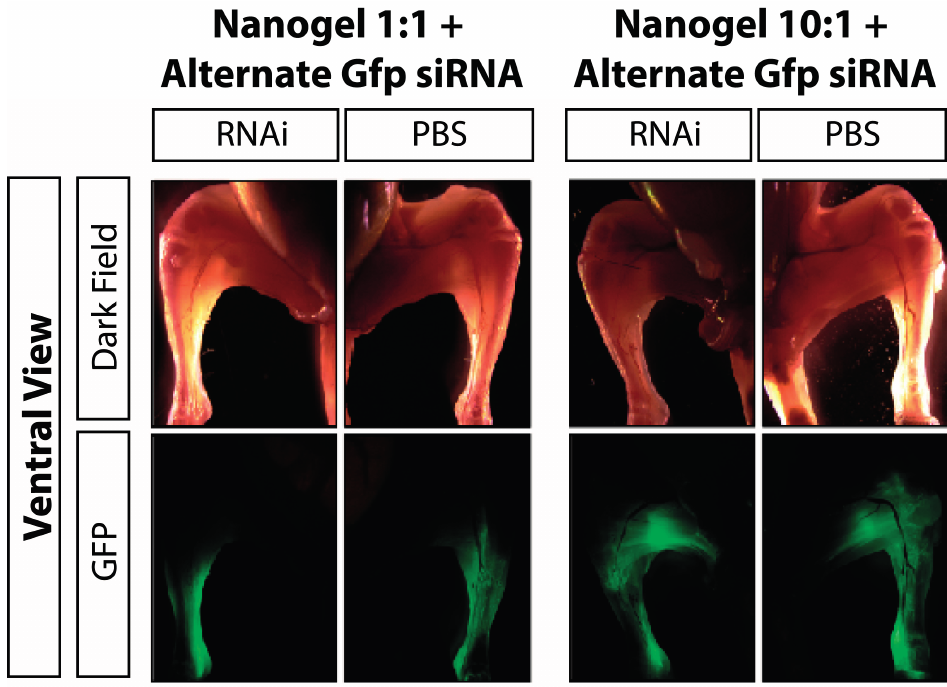
Figure 6. GFP knockdown by delivery of an alternate GFP siRNA sequence. Two μ g of 3’-methylated siRNA for GFP (sequence 2) complexed with nanogel NSPs at 1:1 and